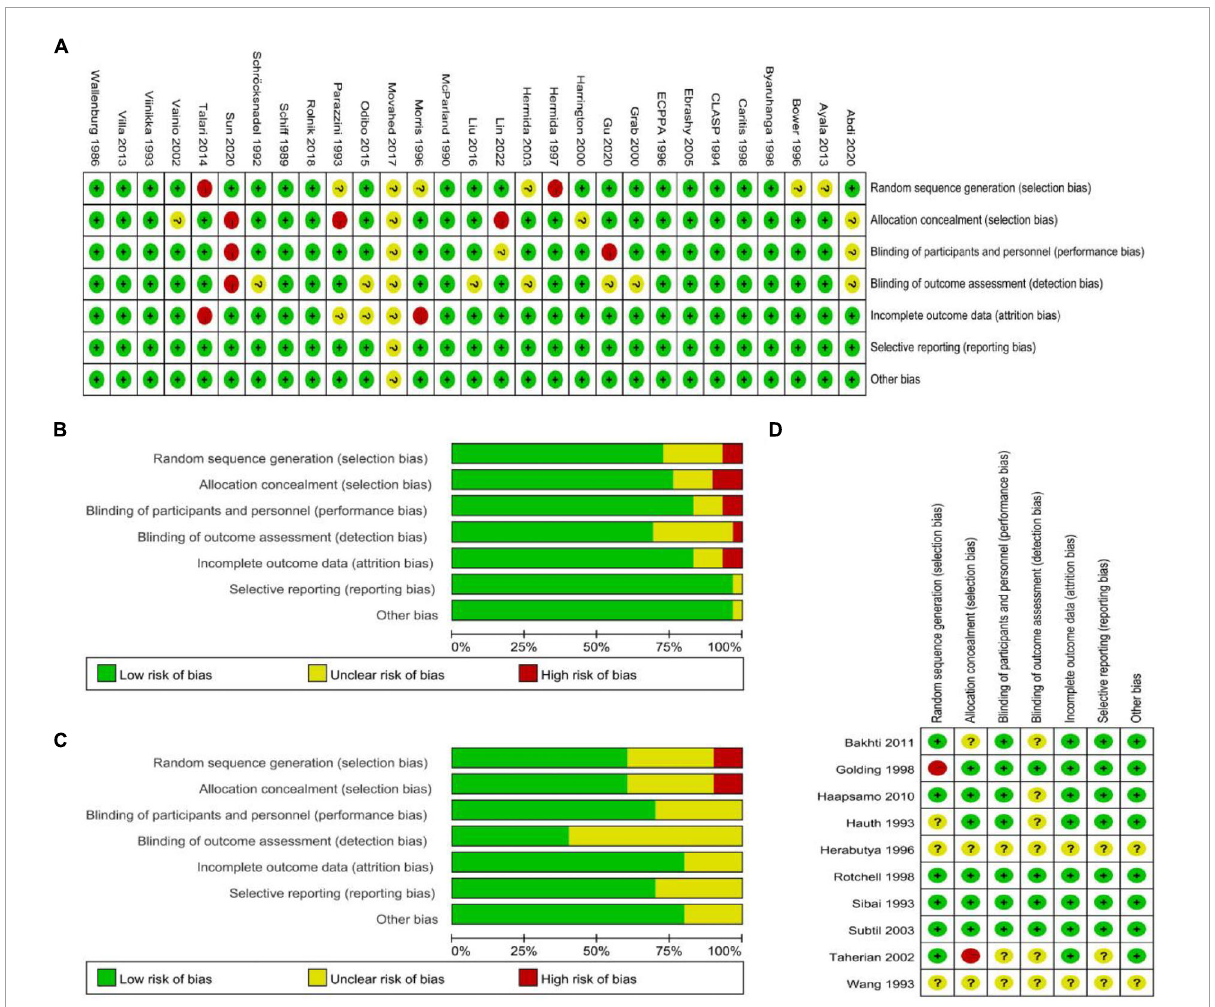
FIGURE4 (A,B) Bias assessment of studies with PE high-risk women. (C,D) Assessment of bias in studies related to the general population of